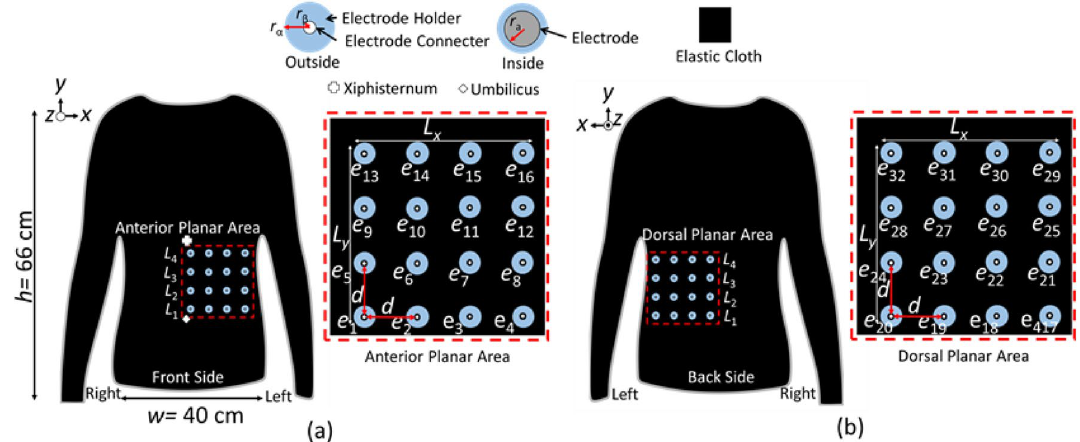
Figure 1. Concept of g EIT suit ( a ). Anterior planar area ( b ) Dorsal planar